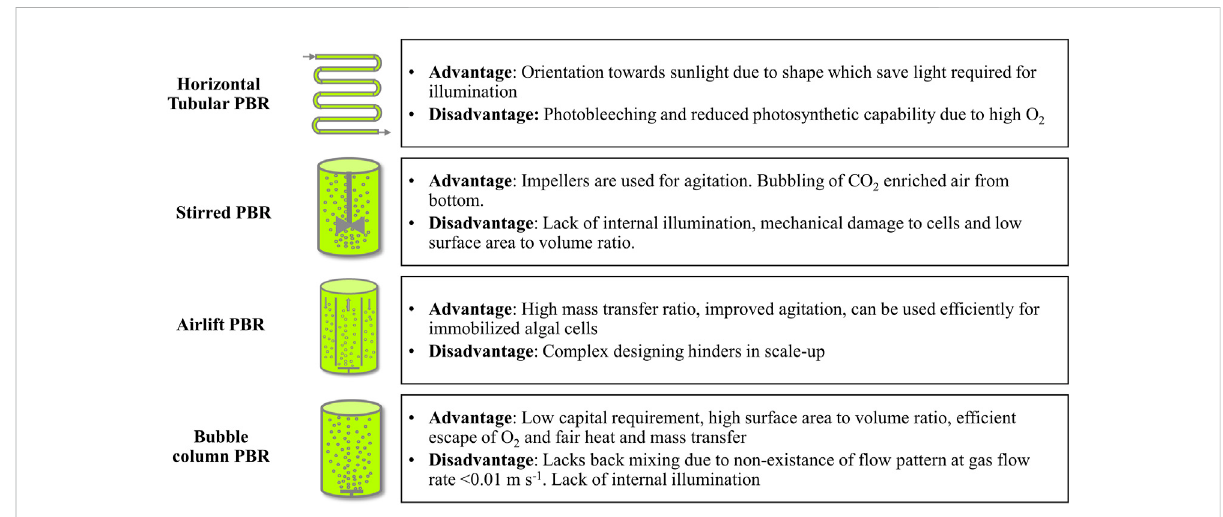
FIGURE 1 Different types of photobioreactors (PBRs) with their advantages and